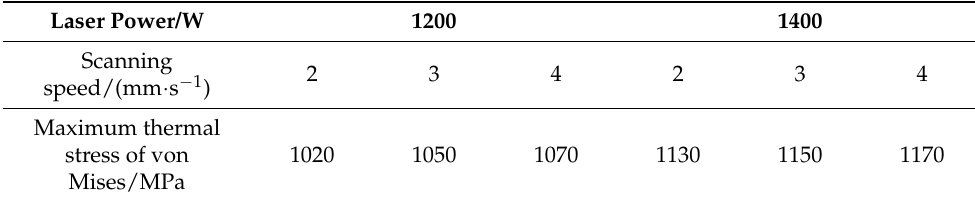
Table 3. Maximum thermal stress of von Mises.